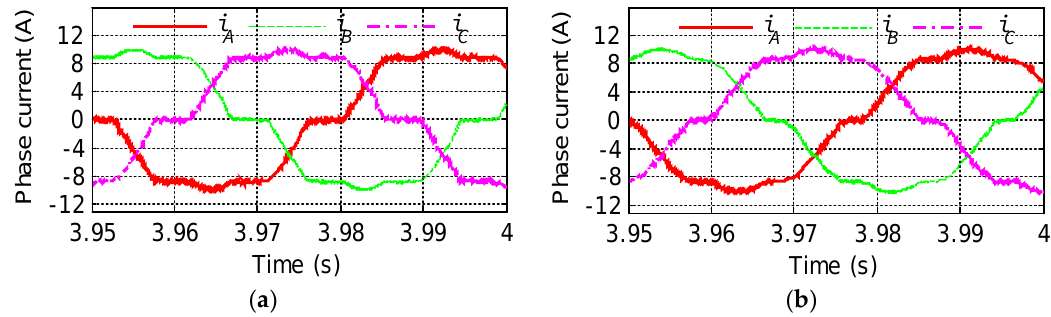
Figure 12. Waveforms of phase currents at 270 r/min: ( a ) Before suppression; ( b ) After suppression.